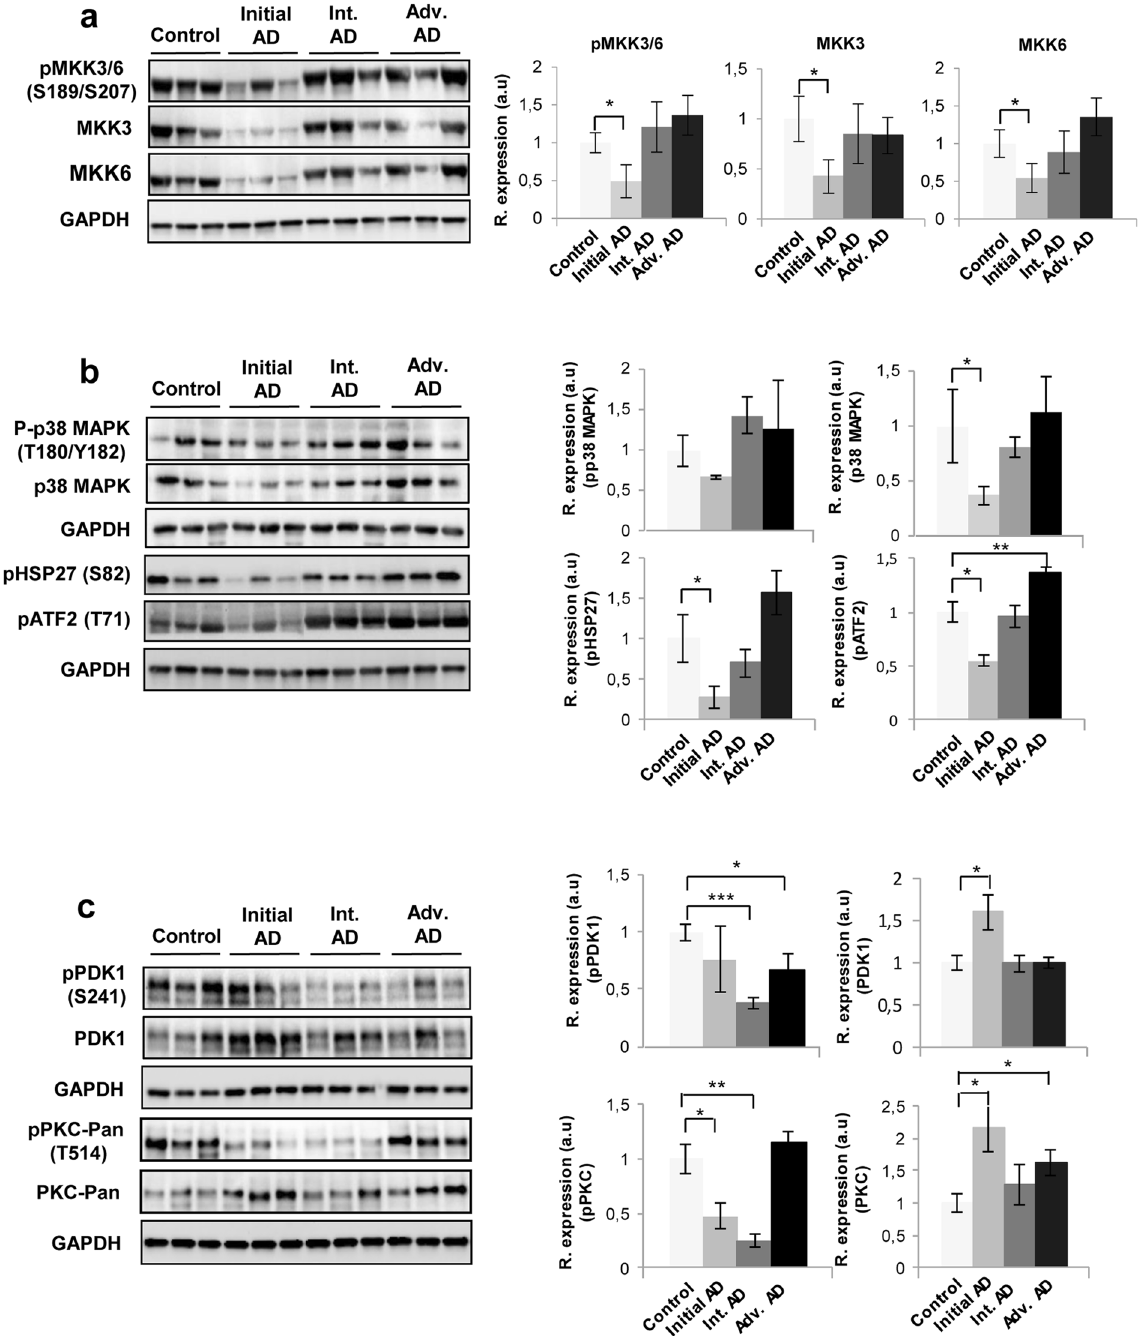
Figure 4. Signaling pathways disrupted in the OB across AD grading. Levels and residue-specific phosphorylation of MKK3/6 ( a ), p38 MAPK, ATF2, and HSP27 ( b ), PDK1, and PKC ( c ) in the OB across AD phenotypes. Equal loading of the gels was assessed by Ponceau staining and hybridization with a GAPDH specific antibody. Right panels show histograms of band densities. Data are presented as mean ± SEM from 5 independent OB samples per group. * P < 0.05 vs control group; ** P < 0.01 vs control group. Representative Western blot gels (n = 3/experimental group) are shown. Full-length blots/gels are presented in Supplementary